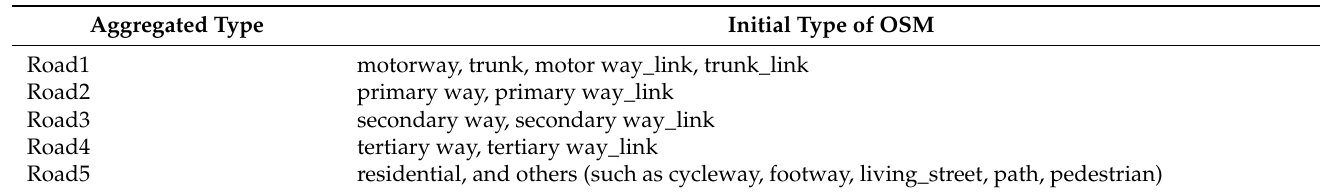
Table A2. Types of original and aggregated